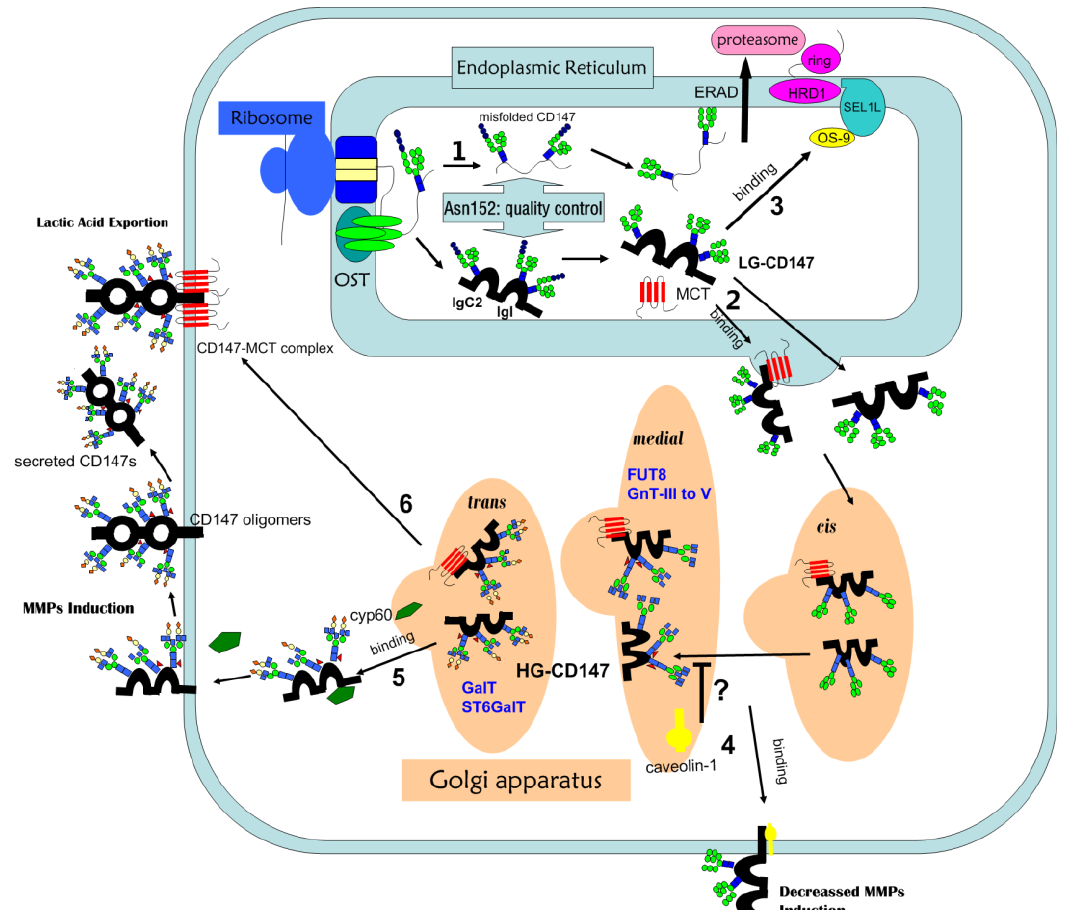
Figure 2. Intracellular biosynthesis and trafficking of glycosylated CD147. Immature high-mannose form of CD147 is modified in the ER, during which 1 glycans on the Asn152 are essential for quality control. Misfolded proteins without Asn152 glycosylation are degraded through ERAD pathway [53]; 2 A part of LG-CD147 then enter the Golgi while 3 the majority of newly produced LG-CD147 are degraded by the proteasome via the OS-9/SEL1L/Hrd1 pathway [54]. In the Golgi complex, LG-CD147 is further modified by many glycosyltransferases including GnT-III, GnT-IV, GnT-V and FuT-8 to form more complicated branching carbohydrate chains [53,55]. Subsequently, terminal modifications such as sialic acids are added to CD147 [56]; 4 Caveolin-1 binds to LG-CD147 in the Golgi, inhibits its maturation and escorts it into the cell membrane. LG-CD147 on the membrane fails to self-associate and induce MMPs [32]. However, it is also reported that caveolin-1 facilitates CD147 maturation [57]; 5 Then, HG-CD147 translocates to plasma membrane during which cyp60 in the Golgi is one of chaperones facilitating the translocation of CD147 [35]. Mature CD147 on the cell membrane form oligomers and a small fraction of transmembrane CD147 are shed and released into the extracellular matrix to act on neighbouring cells. Both forms of mature CD147 are capable of inducing MMPs; 6 MCT is one of ancillary proteins that accompany CD147 during its maturation in the ER and they form CD147-MCT complex on the membrane bearing the double roles of MMPs induction and lactic acid exportion